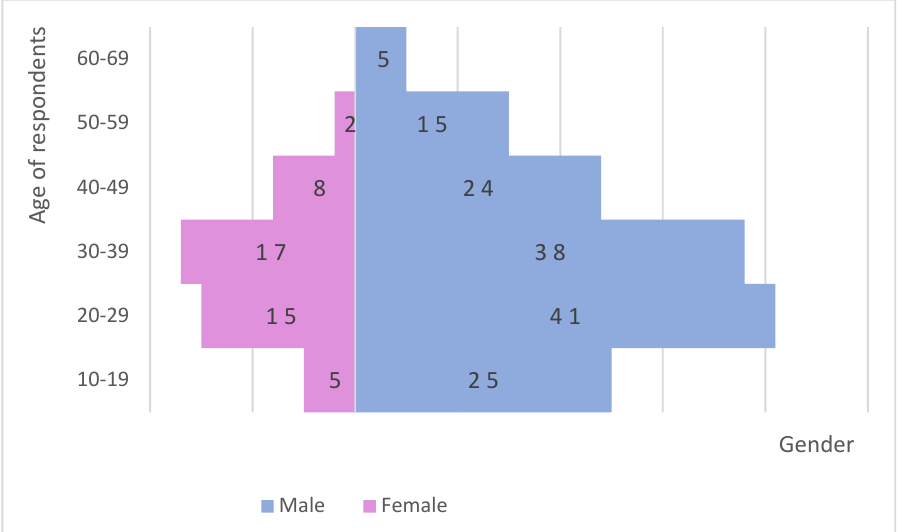
Figure 3. Demographic distribution of respondents.